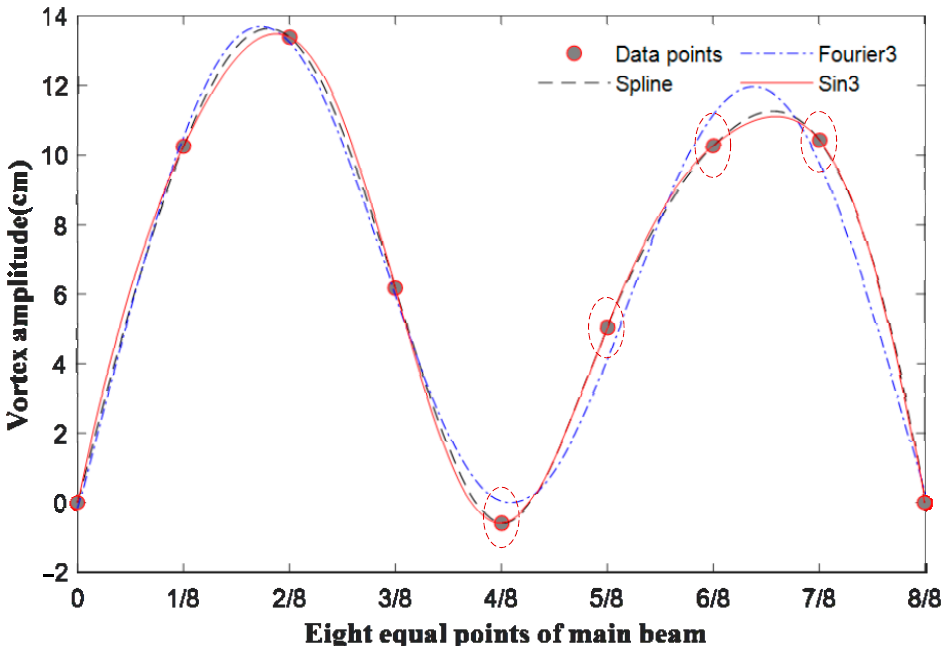
Figure 8. Comparing the fitting effects of the three functions ( indicates that the Fourier series fitting function does not pass through control points, but the other two do).